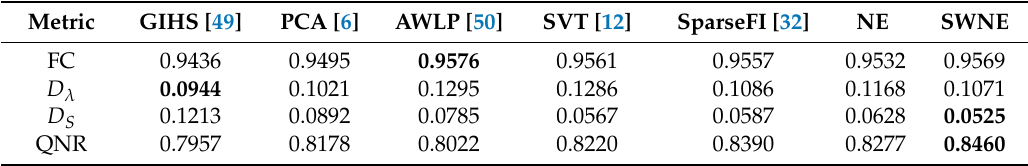
Table 4. Numerical results of each fused image shown in Figure